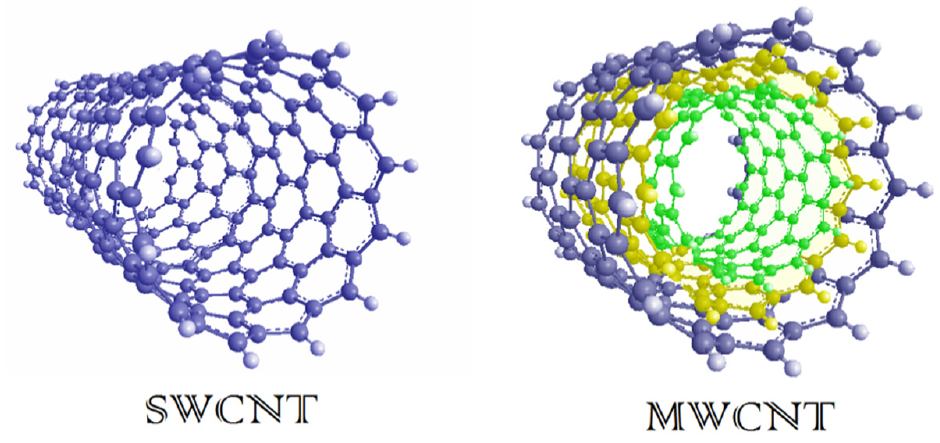
Figure 2. Schematic illustration of the morphological structure of CNT.